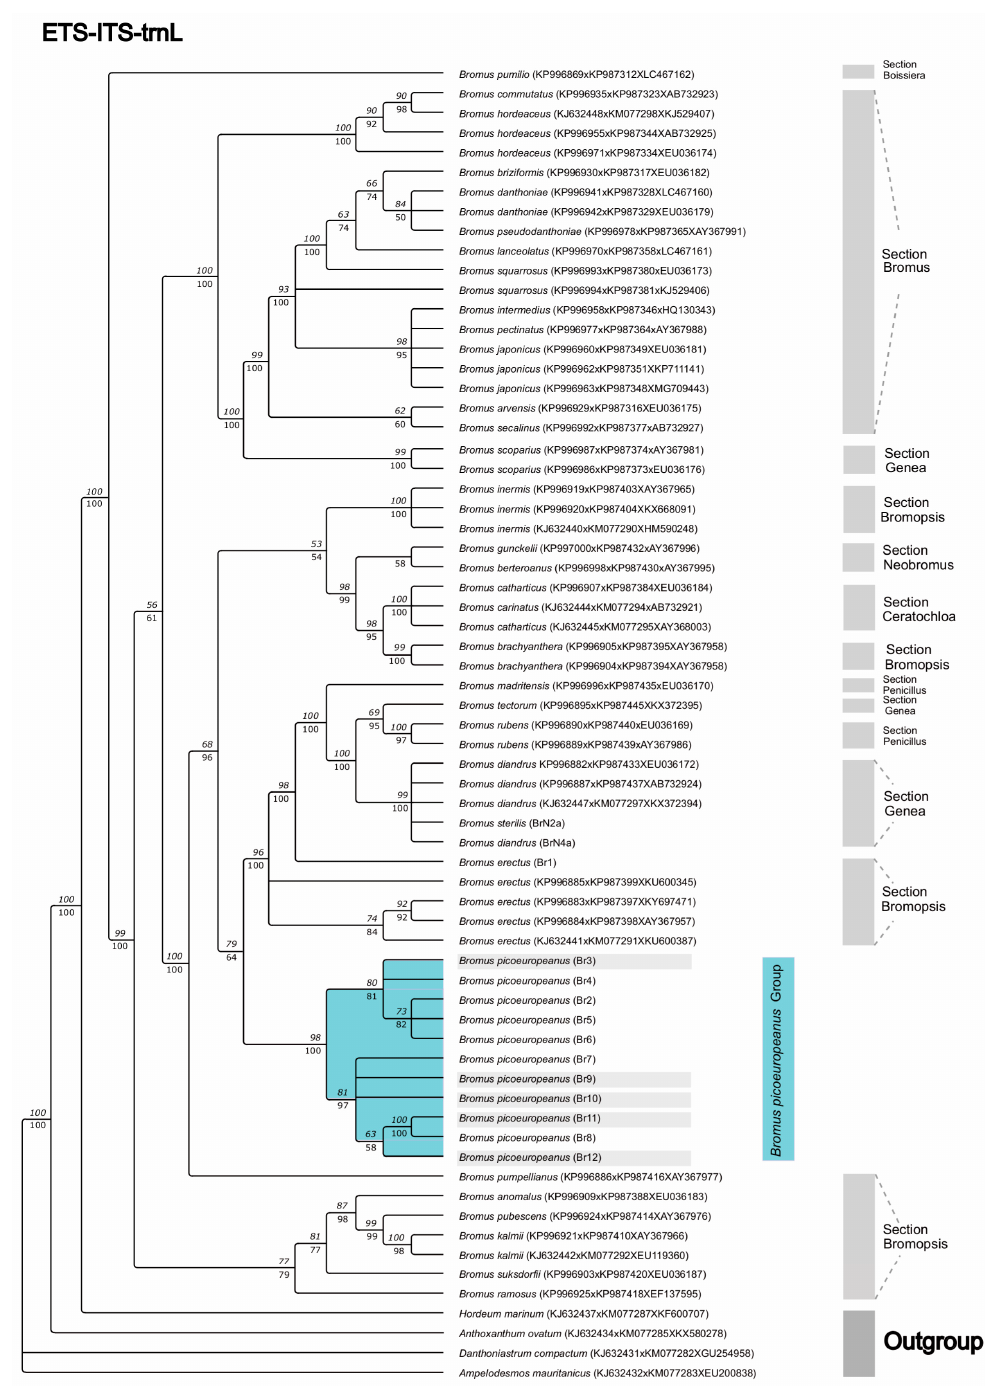
Figure 6. Consensus phylogenetic tree was obtained from ML and BI analyses based on the nuclear and chloroplastic combined sequences ETS-ITS-trnL (UAA). The numbers over and under the branches correspond to the branch support values. The numbers over the branches represent the bootstrap (BS) values obtained from the ML analysis, while the numbers under the branches correspond to the BI analysis posterior probability (PP) values. Br: Bromus samples were generated in this study. The Br samples from the Cantabrian Mountains and from Picos de Europa have been highlighted in blue. The Br samples collected under 1600 m above sea level has been highlighted in grey.